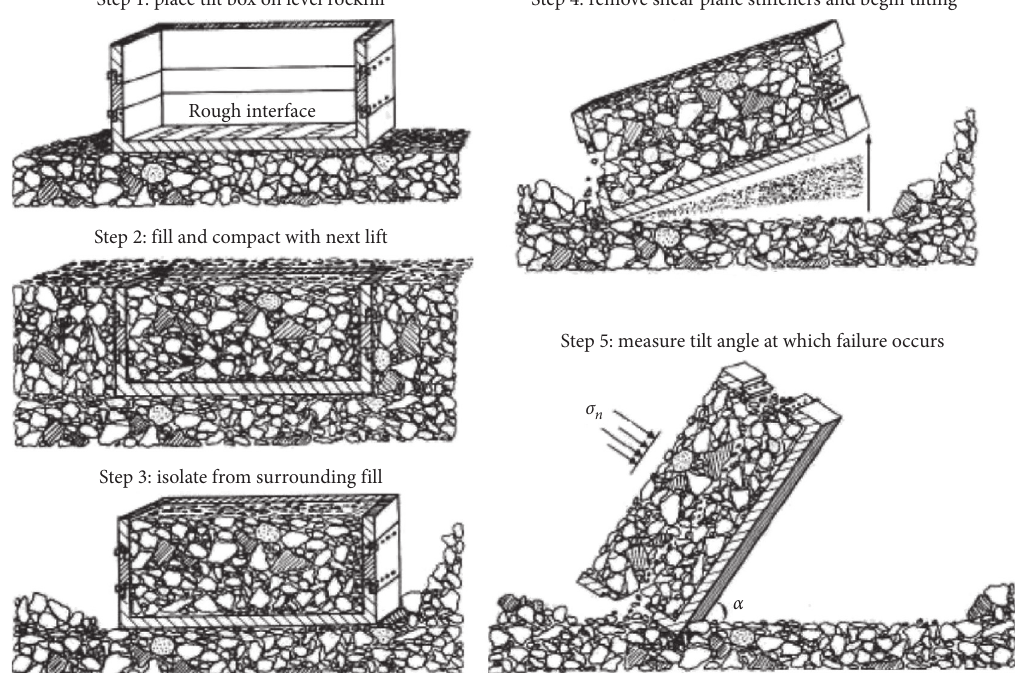
Figure 1: Instrumentation and test procedure of in situ tilt tests on rockfill (reproduced from [51] with permission from